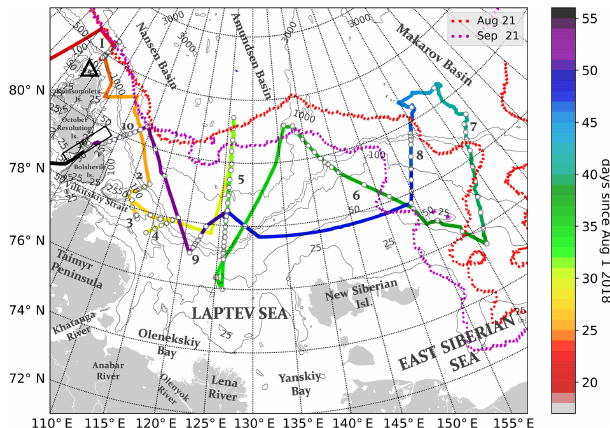
Figure 1. Legs and stations of the ARKTIKA-2018 expedition overlaid on the bathymetry from ETOPO1 “1arcmin Global Re- lief Model” (Amante and Eakins, 2009). CTD stations are shown with white dots. The color indicates the number of days since 1 Au- gust 2018. The sea ice edge position is indicated with a dashed red line for the beginning (21 August) and with a dashed purple line for the end of the expedition (21 September). The ice edge is based on the sea ice mask provided in the DMI SST product. Numbers indicate positions of 10 oceanographic transects discussed below. The black triangle in the north of the Komsomolets Island shows the Arkticheskiy Cape. The Severnaya Zemlya Archipelago con- sists mainly of the Komsomolets, the October Revolution, and the Bolshevik Islands (with smaller islands not shown here). The black box indicates the Shokalskiy Strait between the October Revolution and the Bolshevik Islands. The Yana river estuary (outside the map area) is south of Yanskiy